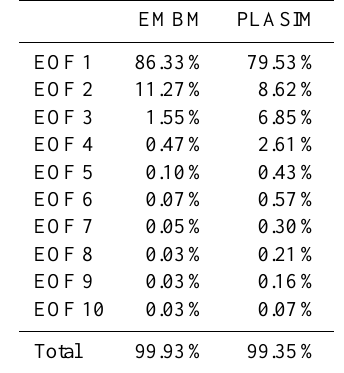
Table 5. Percentage of variance in SAT, explained by the first 10 EOFs for GENIE-1 with EMBM and with PLASIM. The 150- member ensembles are used to obtain these